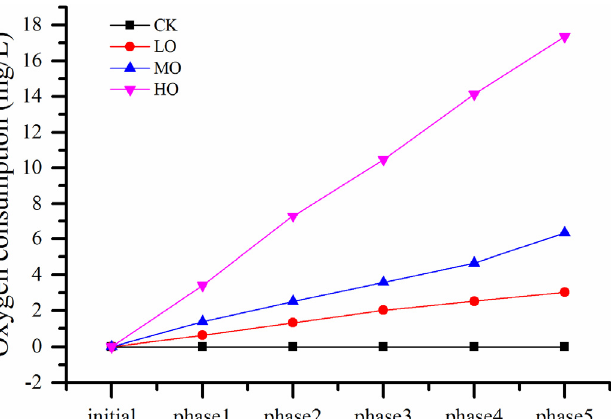
Figure 6. Total oxygen consumption during treatment. Abbreviations: initial, initial wine before oxidation treatment; CK, anaerobic wine (0 mg O 2 /L per time); LO, low-level oxygenation wine (0.5–0.9 mg O 2 /L per time); MO, medium-level oxygenation wine (1–1.9 mg O 2 /L per time); HO, high-level oxygenation wine (3–3.9 mg O 2 /L per time).